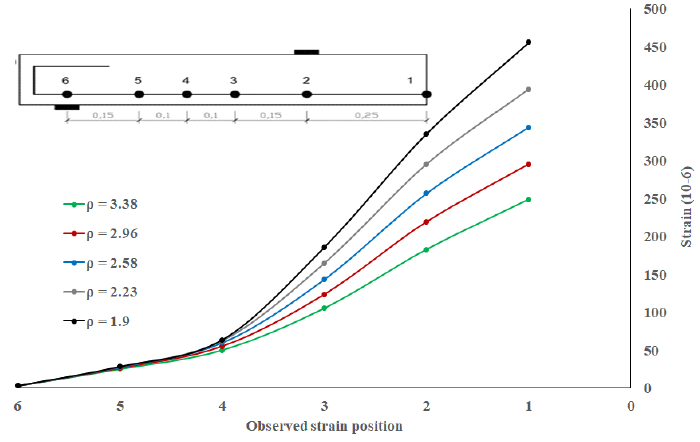
Figure 12. The effect of reinforcement ratio ( ρ ) on the longitudinal strain at various positions.